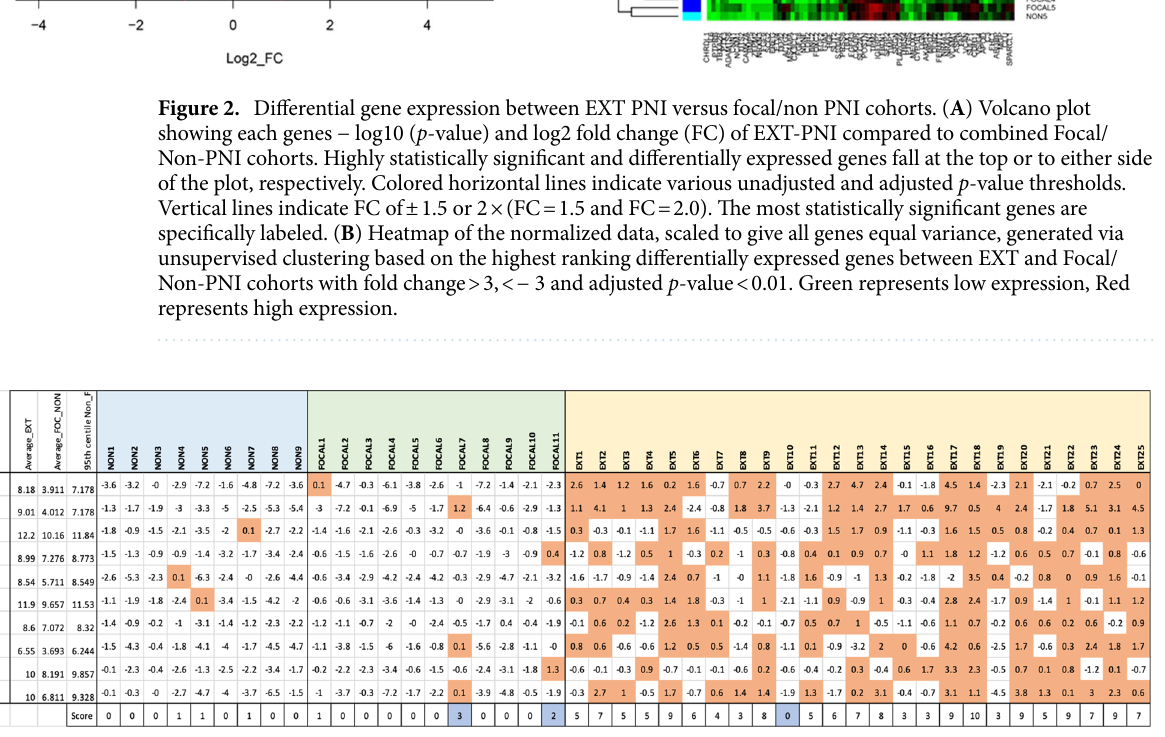
Figure 3. Sensitivity and specificity analysis. Gene panel based on the top 10 most significant genes by adjusted p -value. The 95th centile is calculated for each gene using the outputs of Non and Focal-PNI samples. The 95th centile score is subtracted from each sample. Fields that are positive (i.e. > 95th centile) are given a score of 1 and are shaded orange. The total score is then calculated across all 10 genes to give a combined score out of 10. Outliers (shaded blue) are determined as any Non or Focal-PNI samples with a score of > 1, or Extensive PNI with a Score <